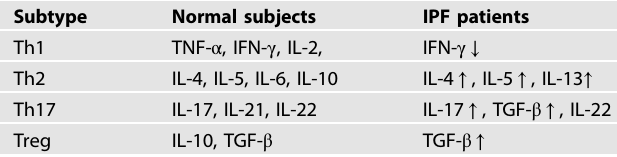
Table 1. Comparing chemokines produced by T cells in IPF patients to those in healthy